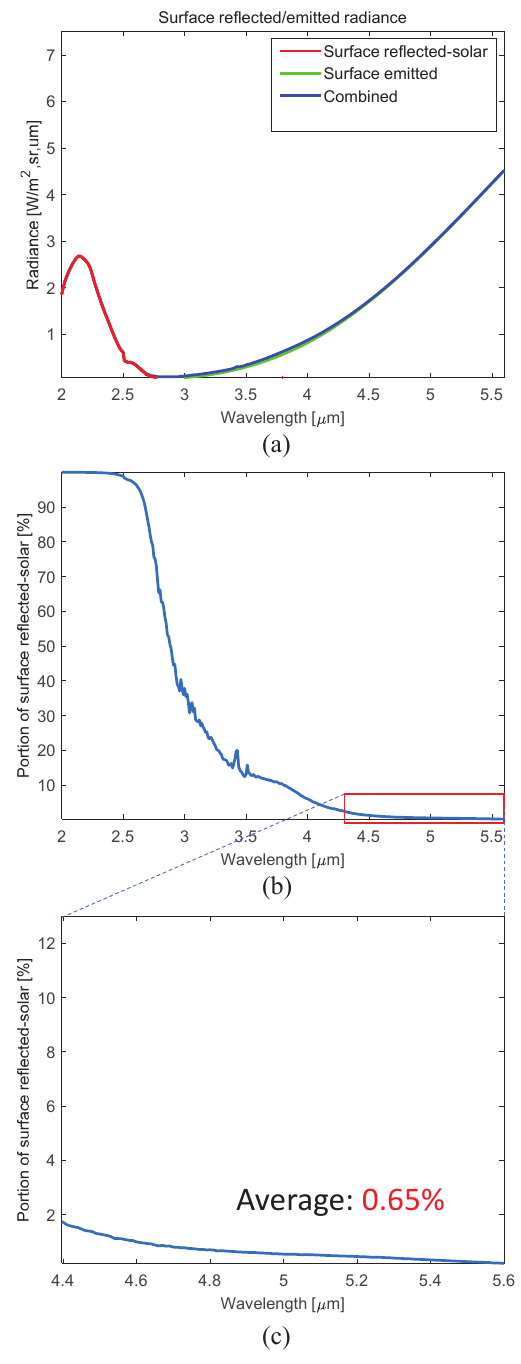
Figure 4. Calculation of the portion of surface reflected-solar: ( a ) surface reflected-solar + surface emitted-object, ( b ) portion of surface reflected-solar [%], ( c ) enlarged view in the upper MWIR